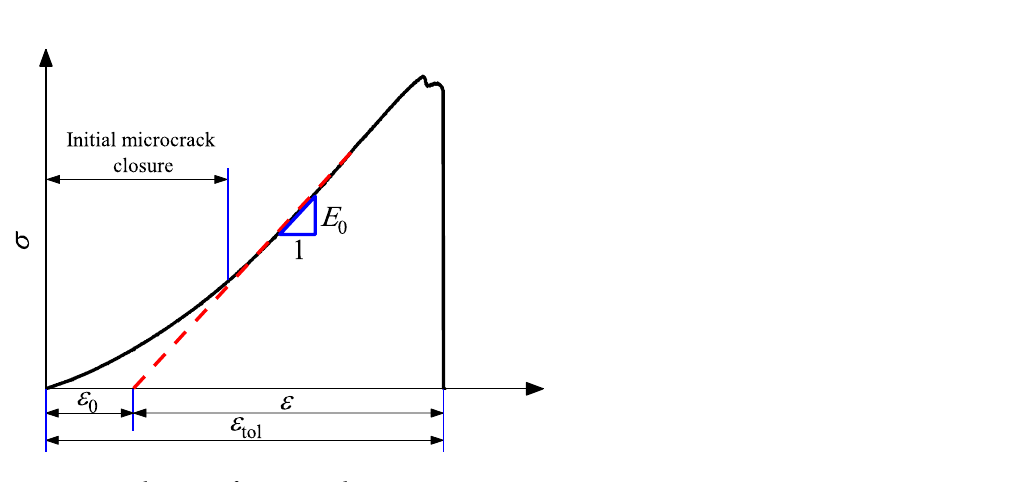
Figure 11. Schematic of E 0 , ε 0 , ε , and ε tol